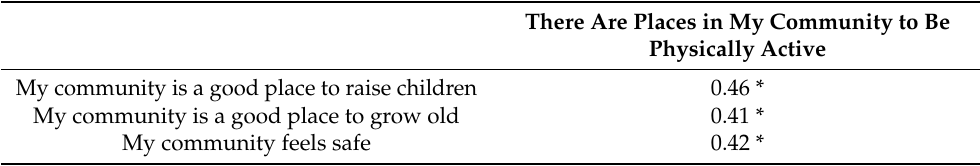
Table 4. Correlations between health indicators and places to be physically active in the community. There Are Places in My Community to Be Physically Active Physical health rating 0.22 * Mental health rating 0.32 * Feeling loved and wanted 0.43 * Feeling socially isolated 0.31 * Feeling down, depressed, hopeless 0.29